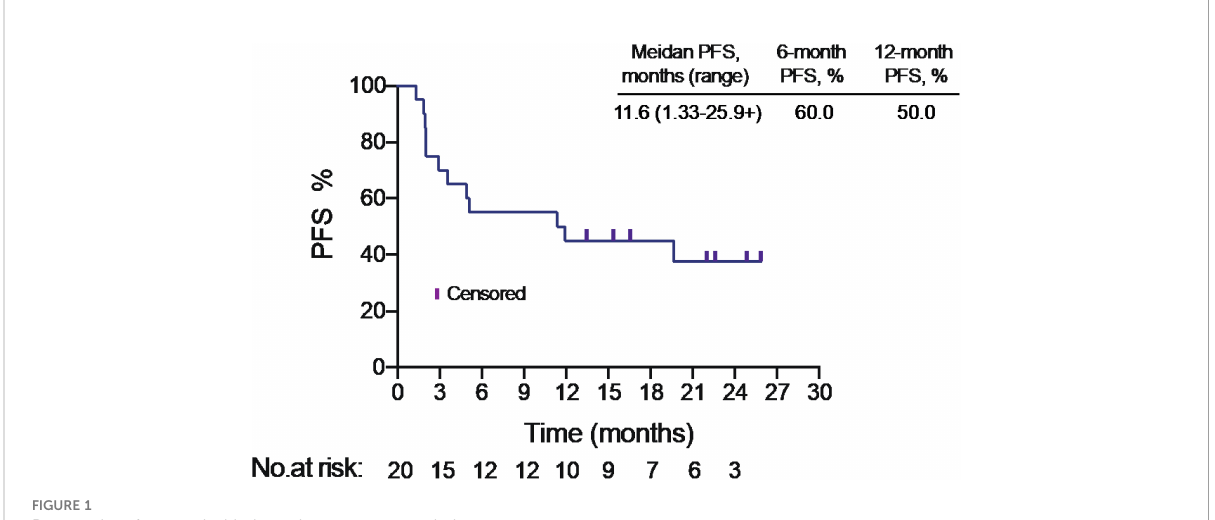
FIGURE 1 Progression-free survival in intention to treat